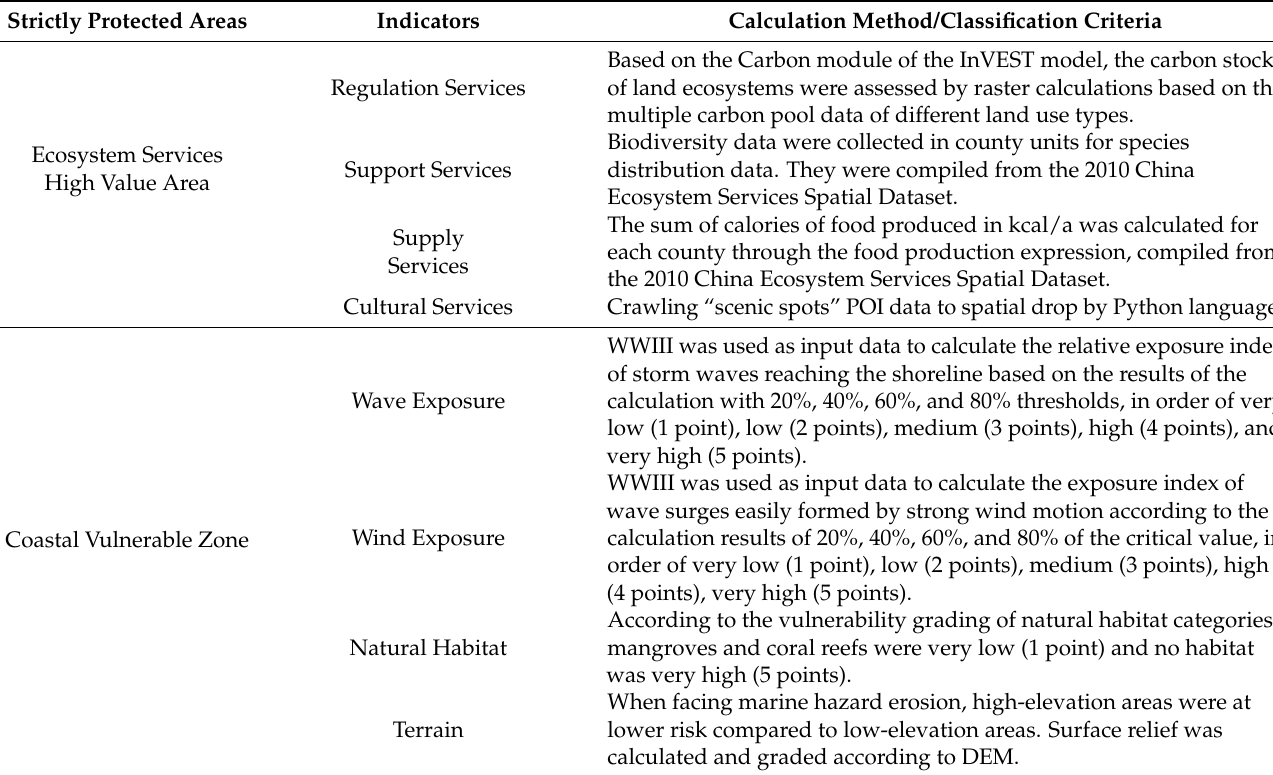
Table 2. Indexes and classification criteria for ES effectiveness and vulnerable coastal